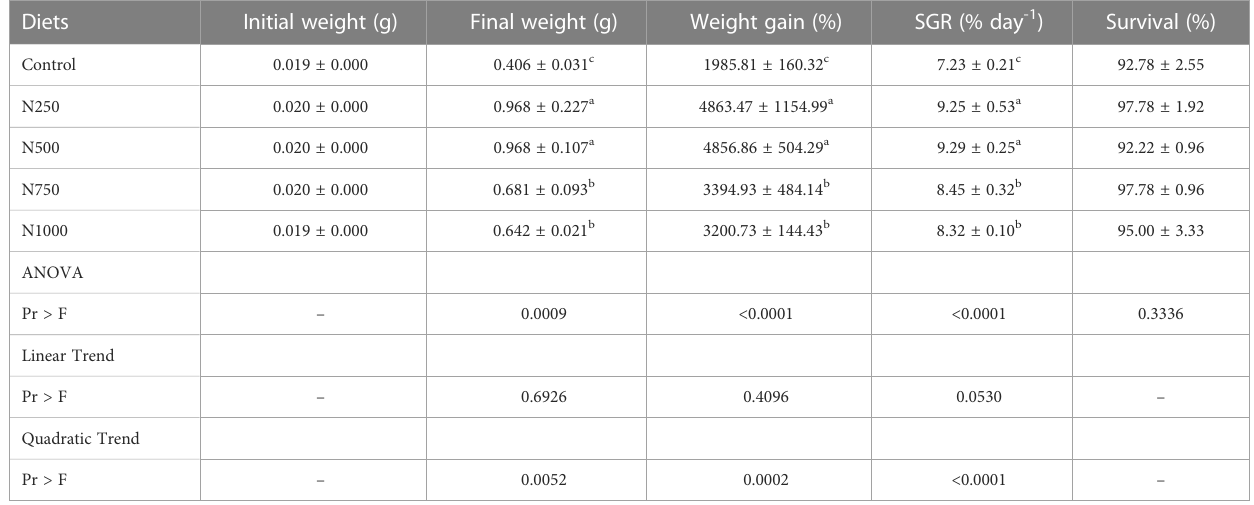
TABLE 3 Initial weight, fi nal weight, weight gain percentage, SGR and survival of white shrimp fed dietary treatments for 6 weeks.